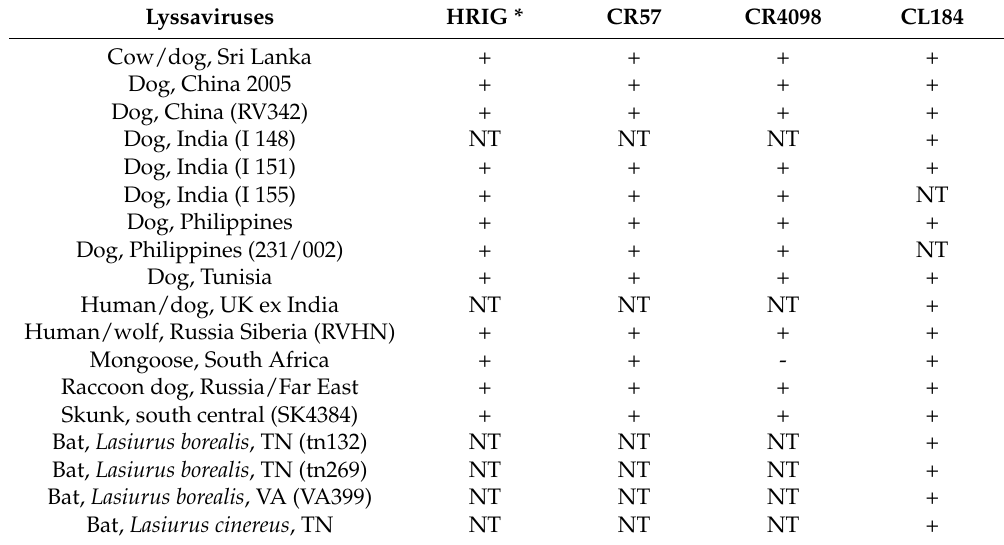
Table 1. Breadth of in vitro neutralization of HRIG, CL184 and its components against selected RABV isolates not covered by previous publications